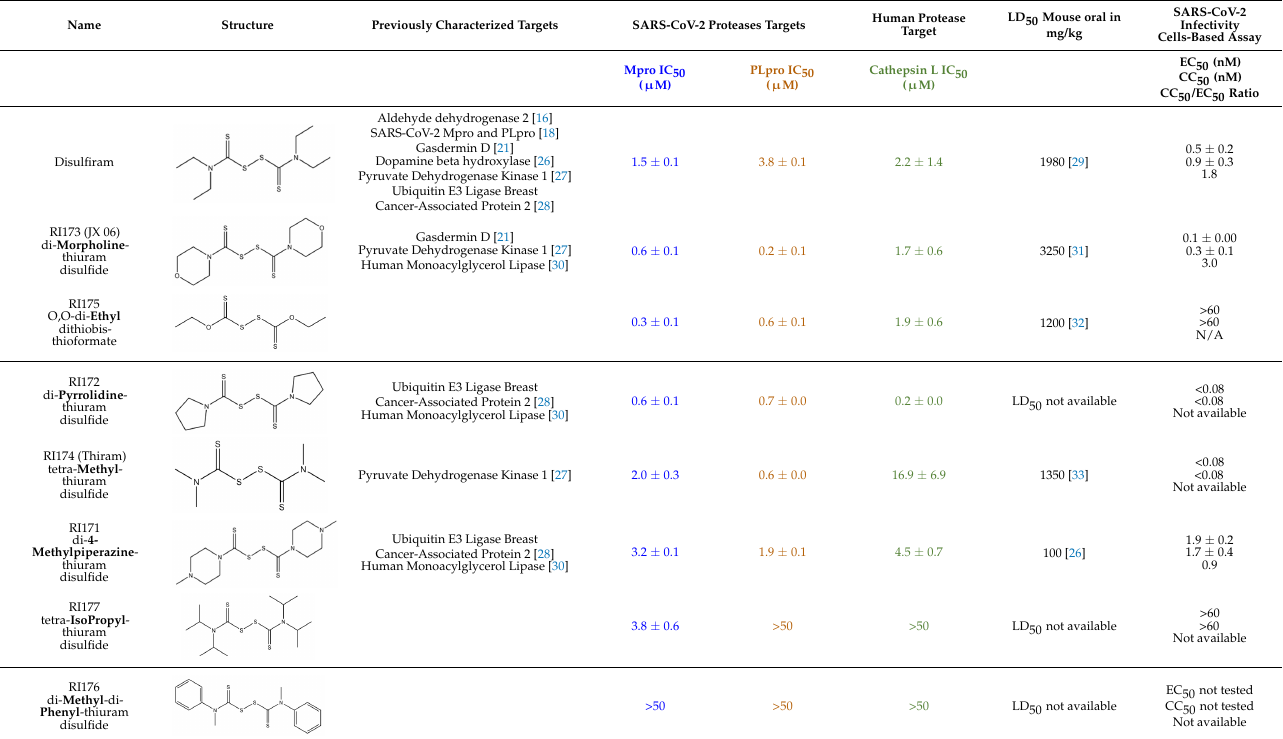
Table 1. Structures of the tested compounds with their known targets, the oral lethal dose 50 (LD 50 ) in mice, and enzymatic assays against SARS-CoV-2 Mpro, PLpro, and human cathepsin L investigated in this study. Numbers in blue, orange, and green show the half-maximal inhibitory concentration (IC 50 ) of the tested compounds against SARS-CoV-2 Mpro, PLpro, and human cathepsin L, respectively. Structure